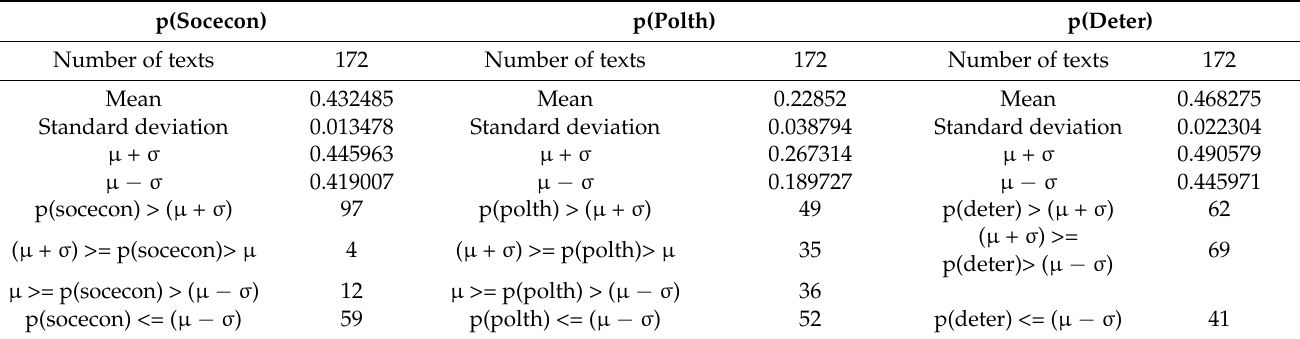
Table 5. The outcomes of formulas for the measures of entrepreneurial